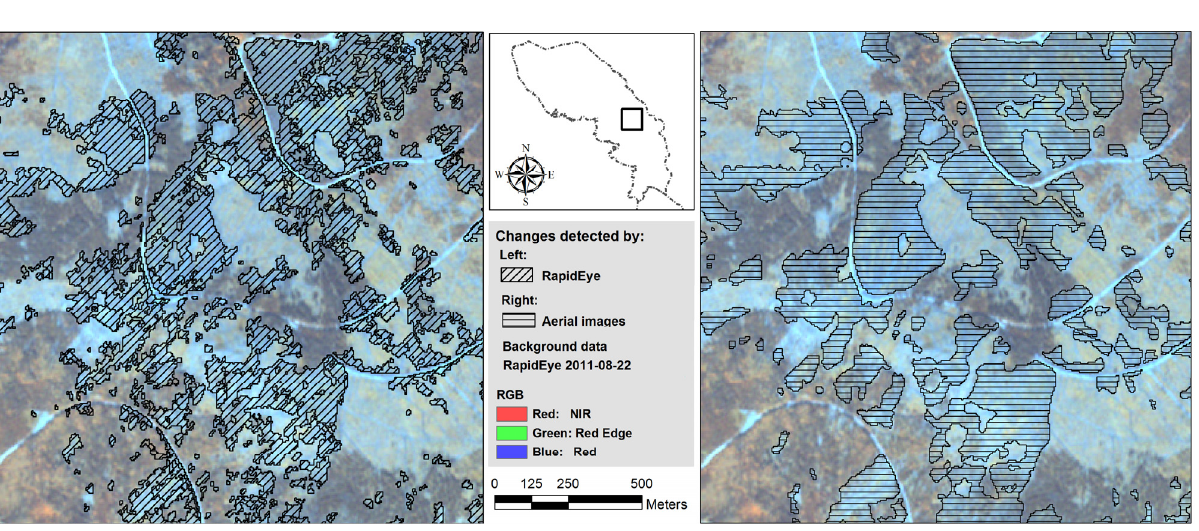
Figure 6. An example showing total forest cover losses during the period from 19 April to 22 August detected using ( left ) analysis of RapidEye data and ( right ) visual interpretation of aerial